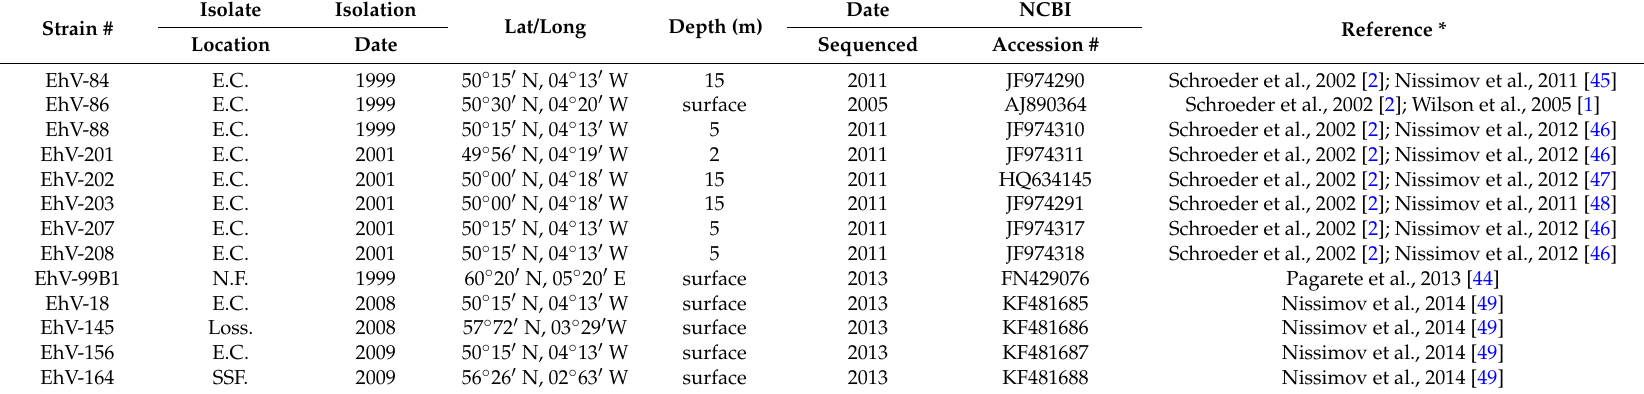
Table 1. A brief description of the coccolithoviruses used in this study, their geographical origin, year of isolation and sea water depth from which they were obtained.